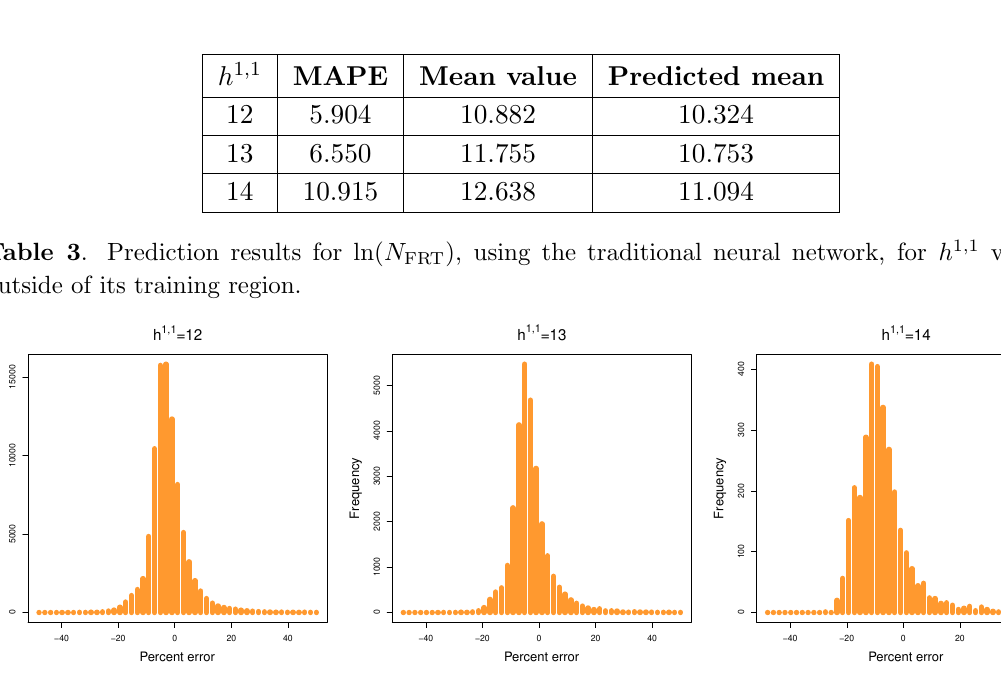
Figure 5 . Histograms of the percent error of the feed-forward neural network’s predictions in the extrapolation region. Compare to extrapolations in the EQL network in (cid:12)gure 7. each with 30 nodes. The (cid:12)rst layer has a sigmoid activation function, while the second has a tanh activation function. The (cid:12)nal layer is a recti(cid:12)ed linear unit (ReLU), meaning that its activation function f is equal to the positive part of its act